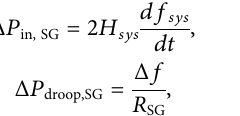
Frontiers in Energy Research |